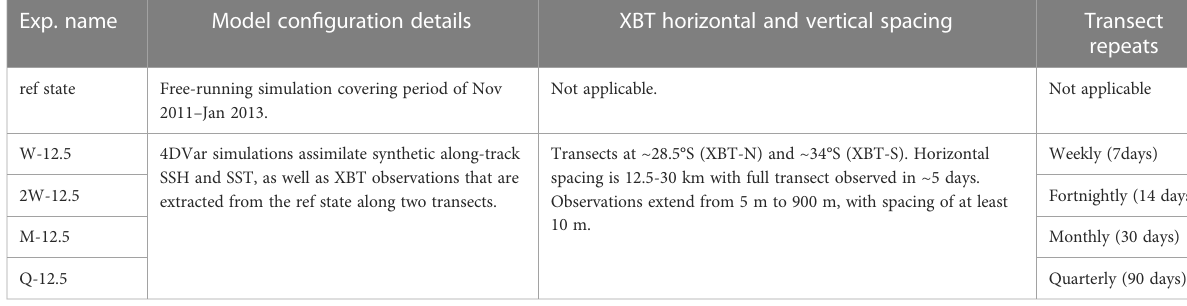
TABLE 1 The con fi gurations of the free-running ref state and the four experiments are described, including the XBT horizontal and vertical spacing and XBT transect repeat time. Exp.